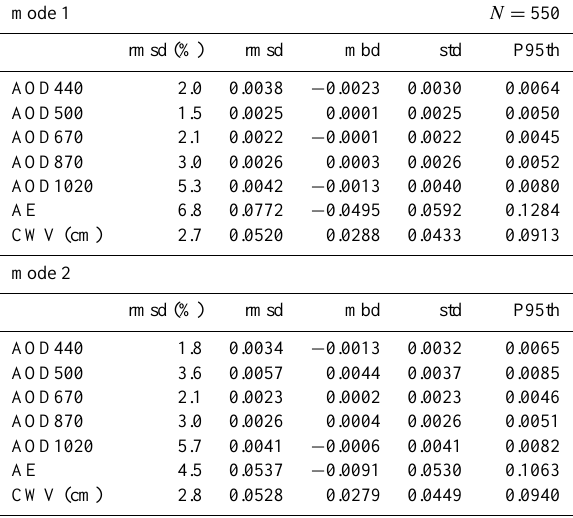
Table 4. Statistics summary (root mean square deviation – absolute and expressed as percentage (%), mean bias deviation, standard de- viation of differences, and 95th percentile) between the CIMEL and the PREDE when the same ESR software is used in mode 1 (top) and mode 2 (bottom). The number of data samples ( N ) is also indi-